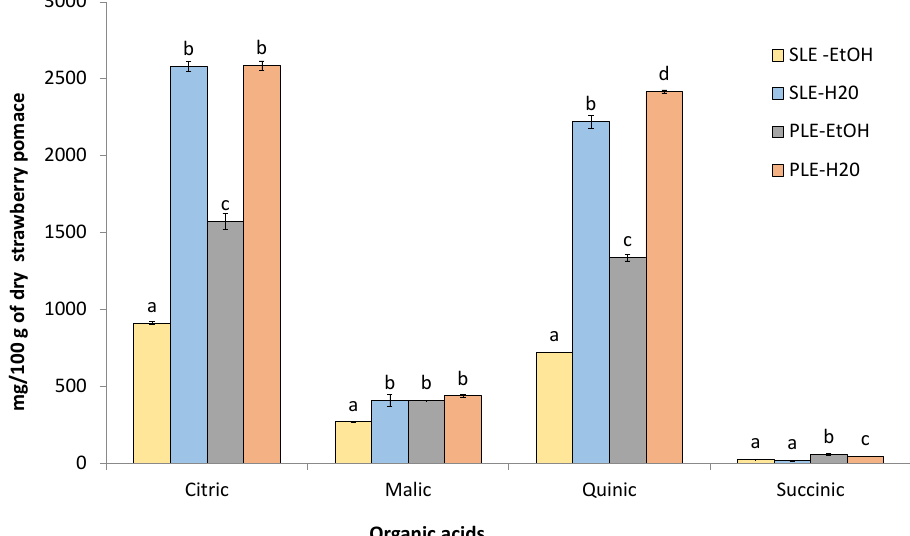
Figure 2. Concentration of organic acids in SLE and PLE extracts of strawberry pomace: the values expressed as means with standard deviations ( n = 3); different letters (a–d) indicate significant differences determined by ANOVA Duncan’s test ( p < 0.05 ).